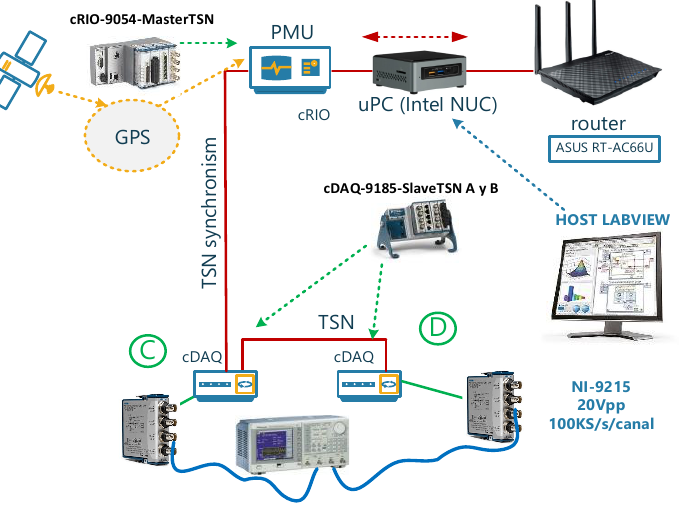
Figure 9. Configuration using 16-bit SAR converters without sensors.